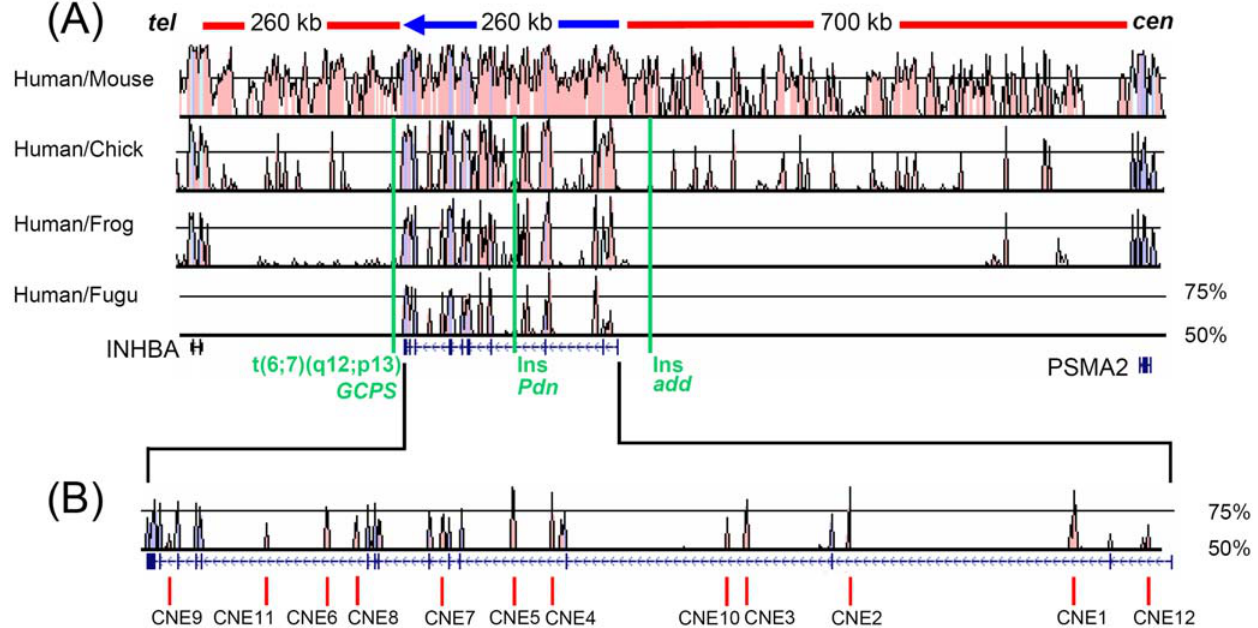
Figure 1. Comparative Sequence Analysis of the GLI3 Locus Detects Conserved Non-coding Sequence Elements. (A) Sequence alignments of the genomic interval containing the human GLI3 locus and flanking human genes INHBA and PSMA2 with orthologous counterparts from representative members of rodent, bird, amphibian, and fish lineages. These are shown as SLAGAN derived VISTA representations. Conserved coding sequences are depicted in blue and conserved non-coding sequences are in pink. Criteria of alignment were 60 bp window and 50% conservation cutoff. Conservation between human and Fugu (scaffold_210 ENSEMBL genome browser) is restricted to the GLI3 gene. Red bars above the conservation plot depict the approximate length of intergenic regions flanking human GLI3. The blue arrow shows the length of the GLI3 gene and the direction of transcription. A graphic representation showing exons and introns of GLI3 is shown below the homology plot. Green vertical lines indicate the positions of alterations affecting the genomic structure of the locus which result in loss of GLI3 function: a translocation event associated with Greig cephalopolysyndactyly syndrome (GCPS) [36], and two insertions (ins) in mouse mutants anterior digit pattern deformity ( add ) [7,37] and polydactyly Nagoya ( Pdn ) [38]. (B) Magnified view of the human/ Fugu conservation plot and the genomic structure of human GLI3 . The red vertical bars below the plot show the position of human/ Fugu highly conserved non-coding sequence elements (CNEs) that were functionally tested as putative enhancers.